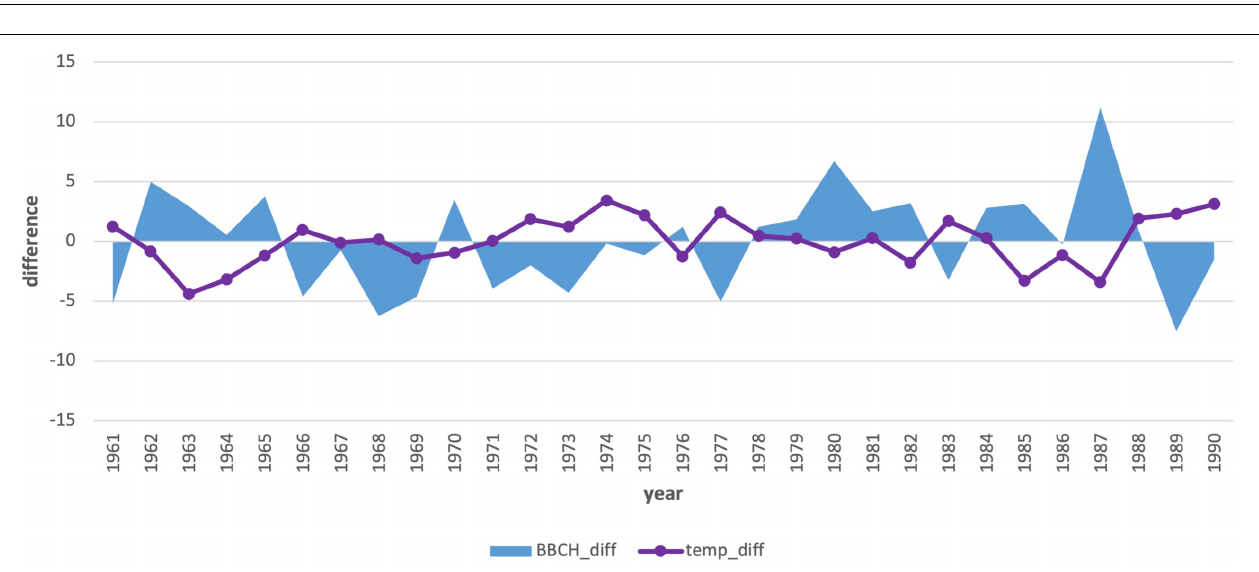
FIGURE 8 | Comparison of deviations of the average monthly air temperature in January with deviations of the onset of the phenological phase from the long-term average for 1991–2020.